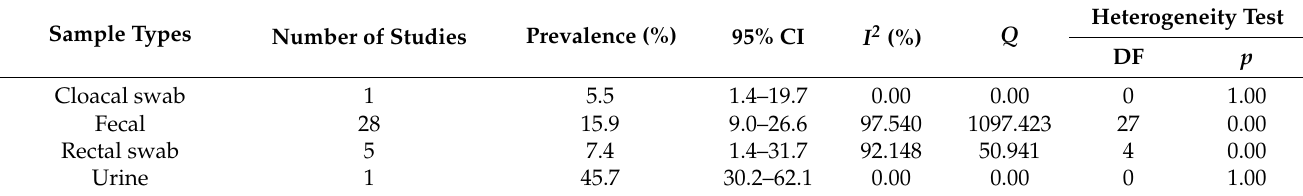
Table 5. Subgroup analysis for comparison of prevalence of VRE in companion animals according to sample types.